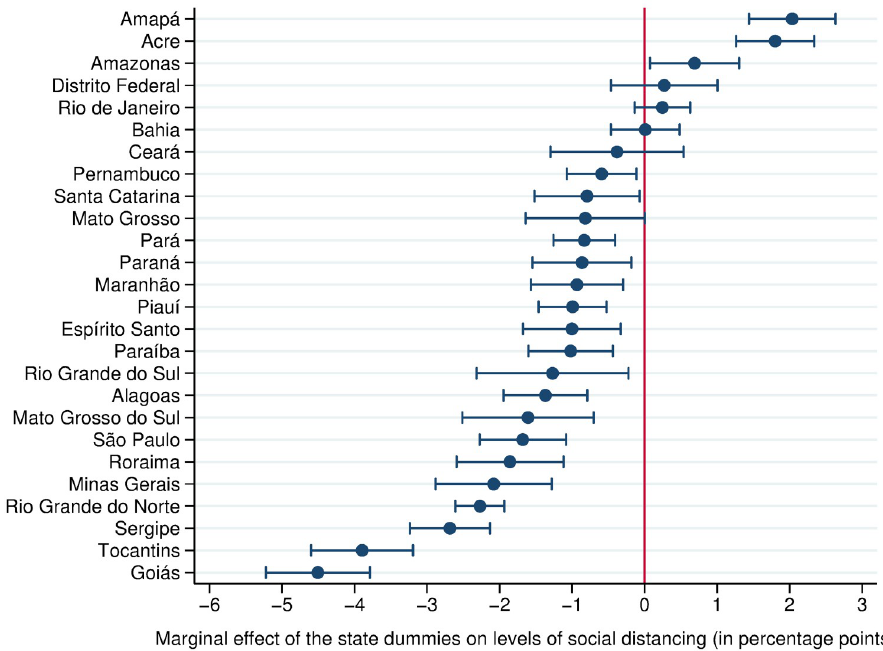
Fig 3. Social distancing levels across different Brazilian states: Estimated coefficients of the state dummies (11 th March– 10 th November 2020). The state of Rondoˆnia was randomly selected as the state of reference. Coefficients represent the expected difference in social distancing levels relative to the state of Rondoˆnia, controlling for the six different types of restrictions, number of days since the first social distancing measure was introduced and whether wearing a mask was mandatory (as in model 7, R 2 = 0.72). Error bars indicate 95% confidence